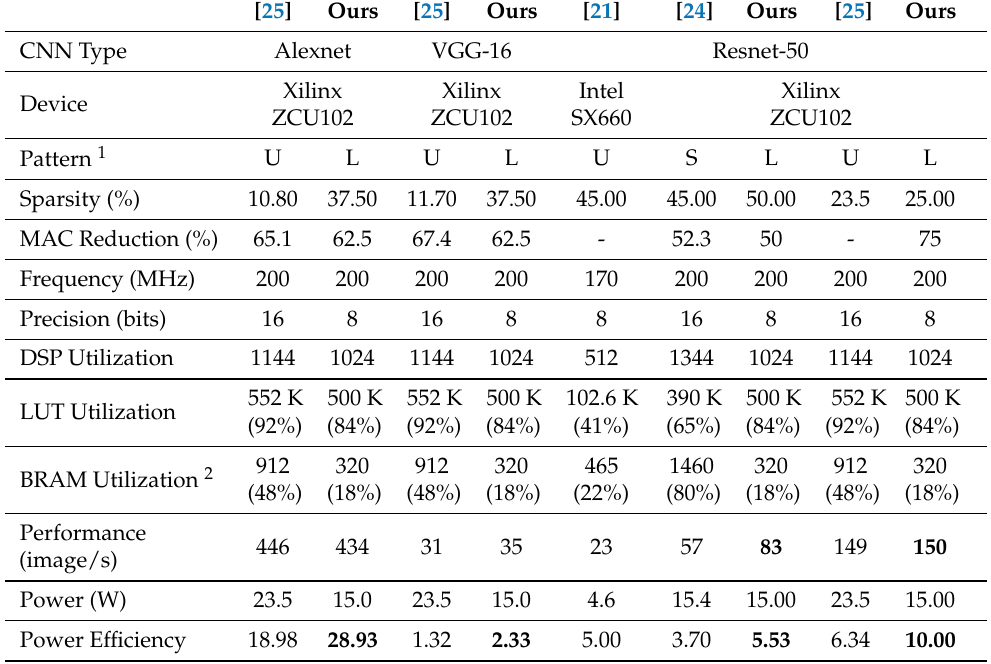
Table 5. Sparse Accelerator Performance